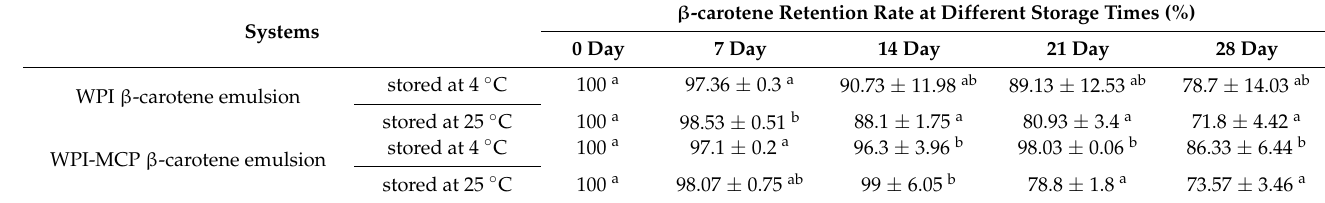
Table 3. β -carotene retention rate of emulsions during